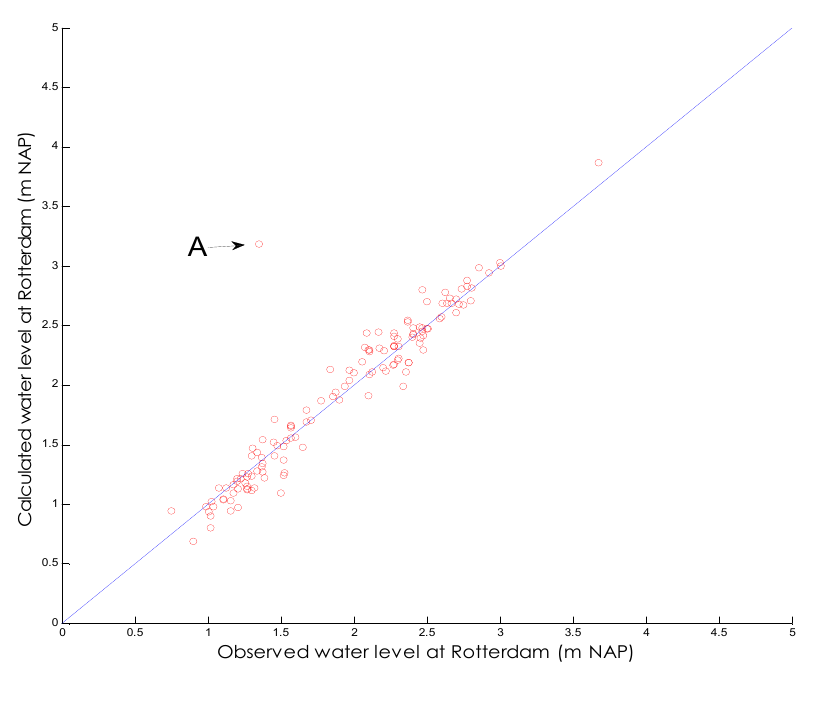
Figure 5. Comparison of the observed and simulated water levels at